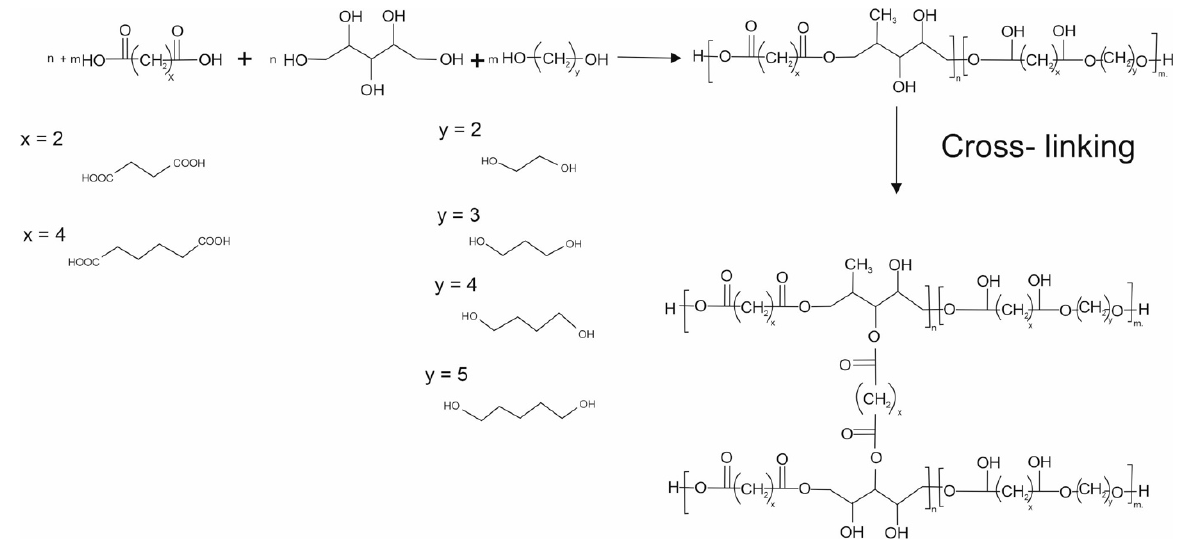
Figure 1. Scheme of the poly (xylitol dicarboxylate-co-diol dicarboxylate) synthesis. Table 1. Composition and selected properties of poly (xylitol dicarboxylate-co-diol dicarboxylate) before and after irradi- ation.